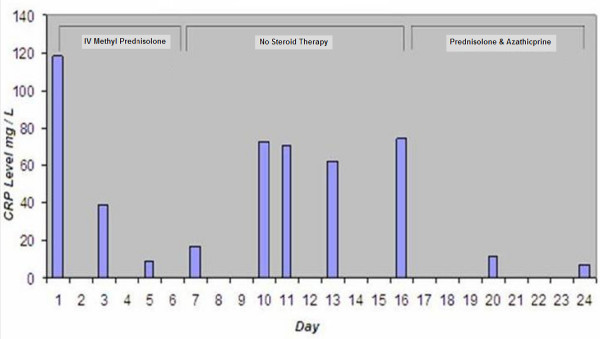
Biochemical response to steroid and immunosuppressive therapy.